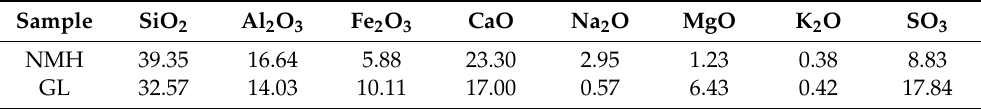
Table 2. Ash composition in